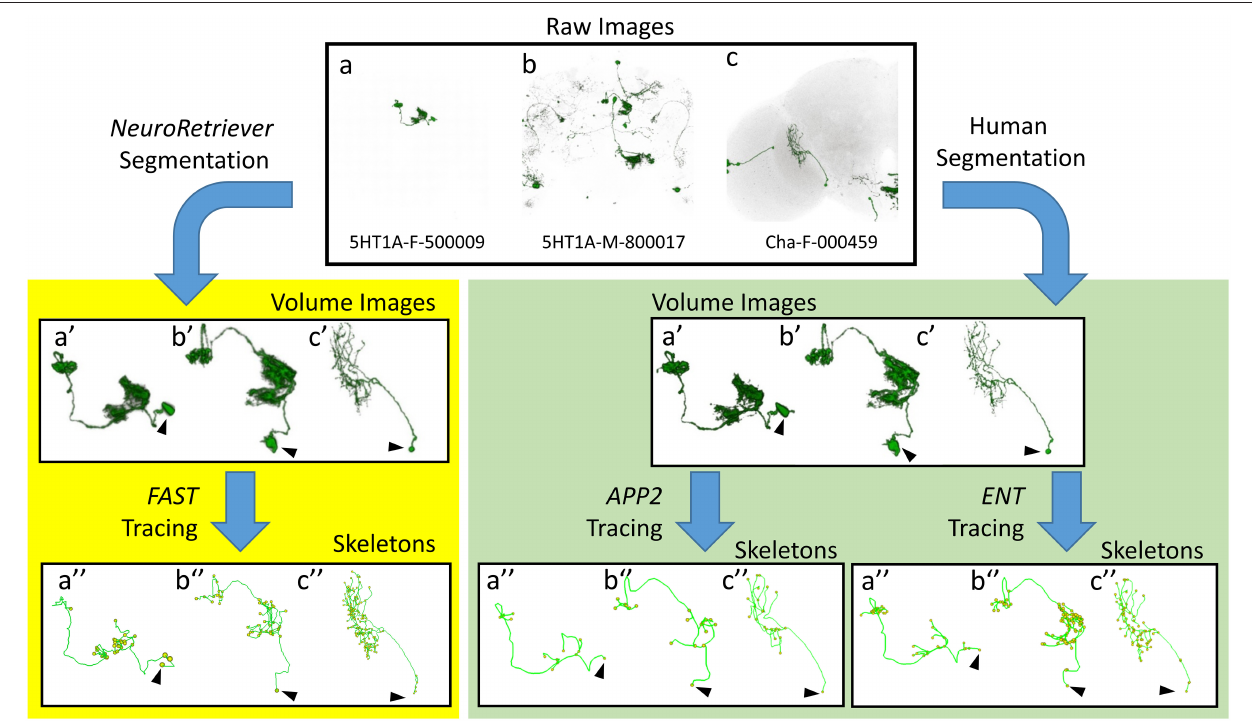
FIGURE 5 | Comparison between FAST -traced skeleton and APP2- and ENT -traced skeletons. Upper panel: Examples of three different types of raw image quality. (a) 5HT1A-F-500009: a single neuron in the brain with clean background. (b) 5HT1A-M-800017: multiple single neurons with clean background. (c) Cha-F-000459: multiple neurons with noisy background. Yellow panel: FAST -traced skeleton from the NR -segmented neurons. Green panel: APP2 - and ENT -traced skeleton from the human-segmented neurons. Arrowhead indicates the cell body. types, and consistent between different runs for the same